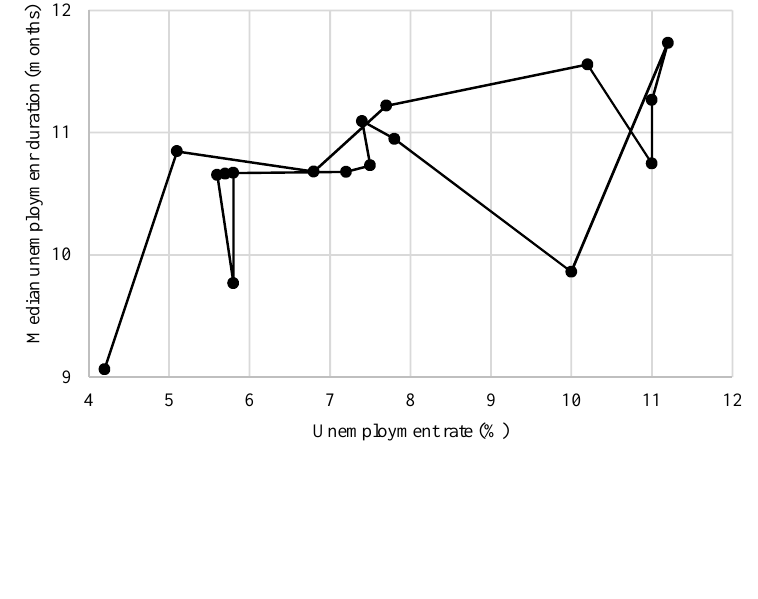
Figure 7. Relation between the unemployment rate and the median